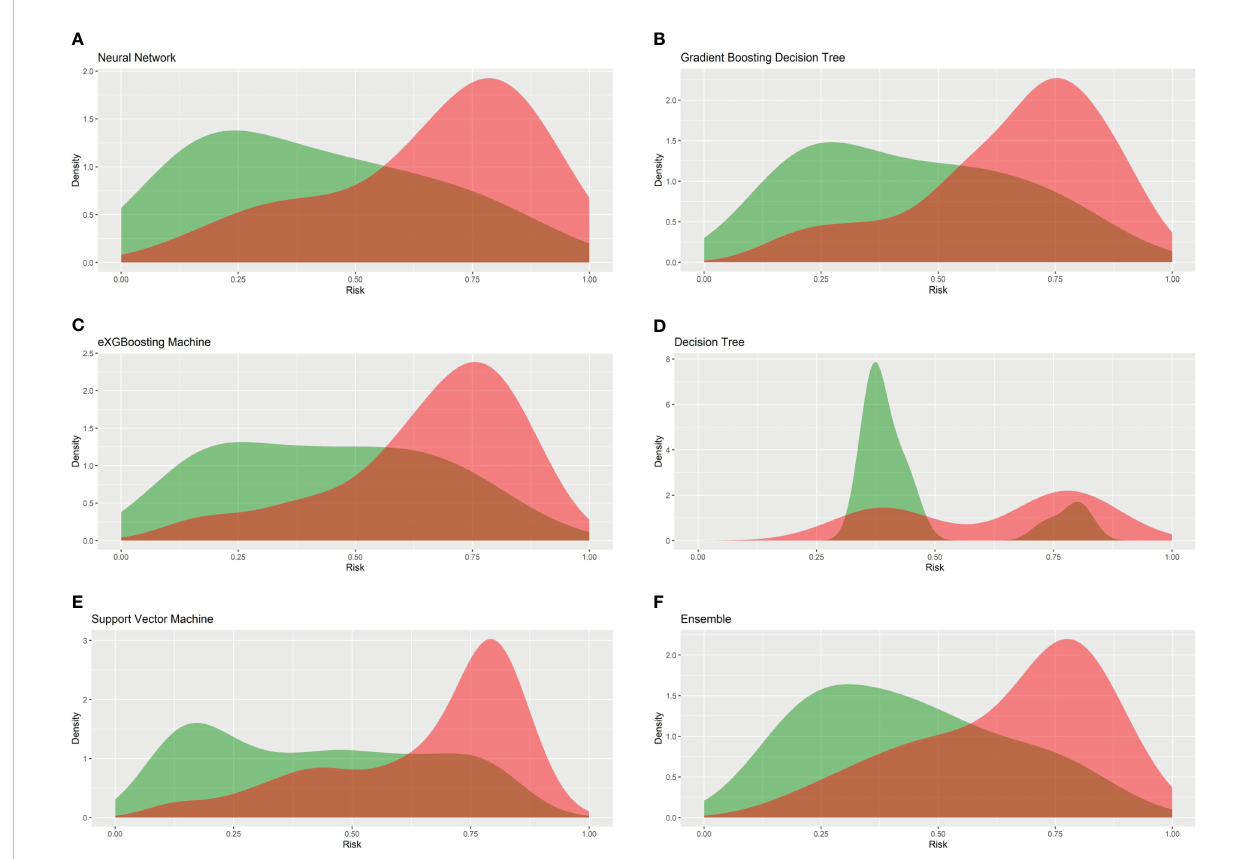
FIGURE 3 Density cures of the machine learning models in the internal testing cohort. (A) Neural network; (B) gradient boosting decision tree; (C) eXGBoosting machine; (D) decision tree; (E) support vector machine; (F) ensemble